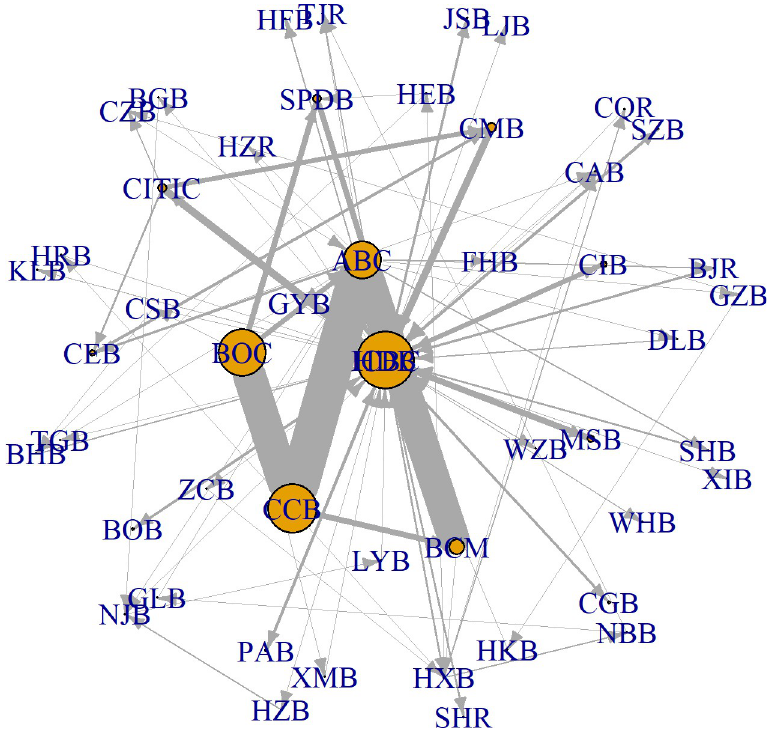
Fig 7. The optimized interbank network in 2010. The interbank networks before and after optimization of the other nine years are shown in Fig S4 of Appendix D in S1 File.